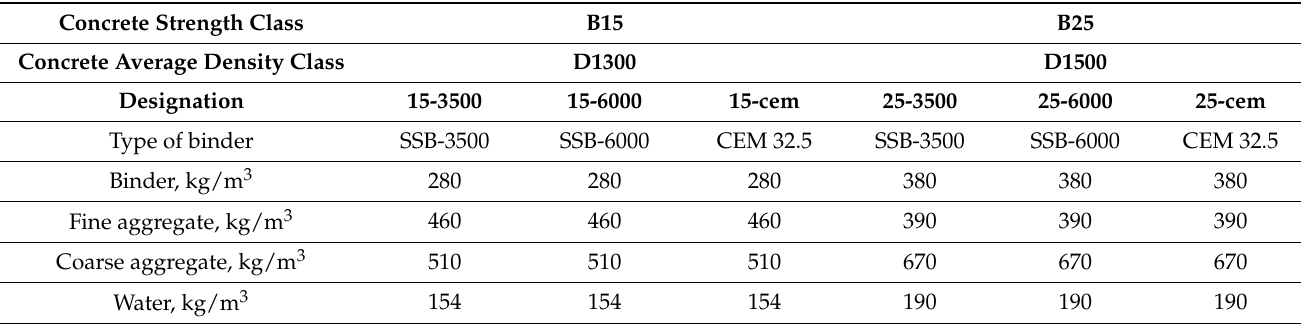
Table 6. Compositions of lightweight